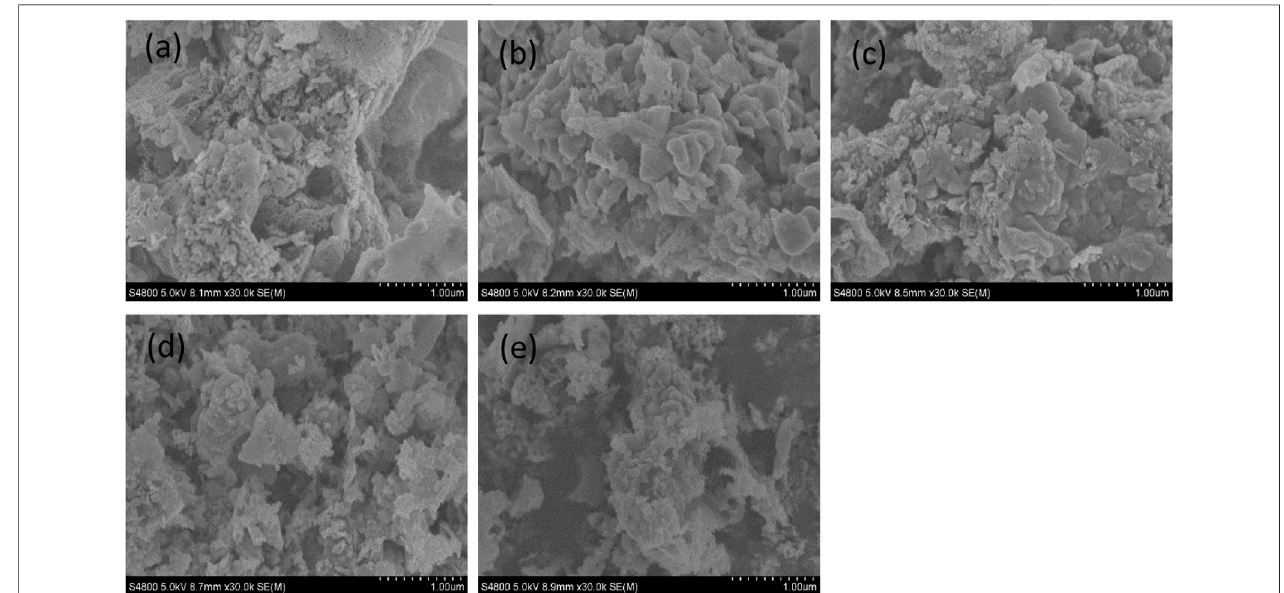
Frontiers in Materials |